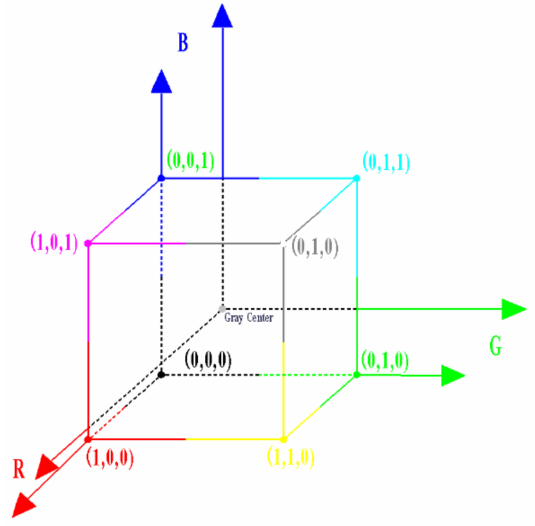
Figure 1. Gray-center RGB color